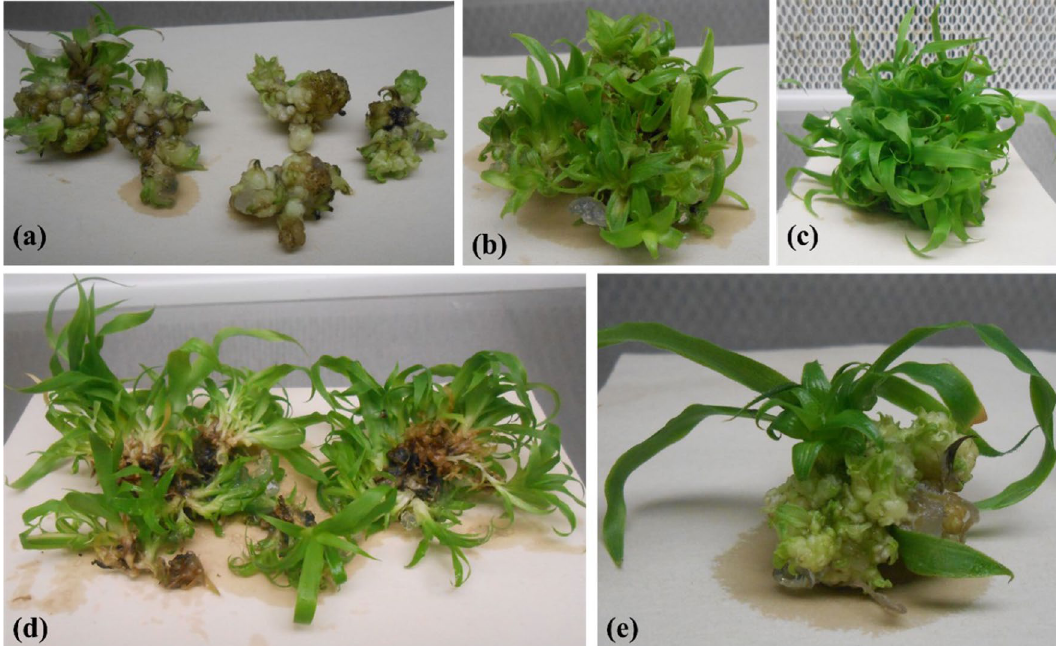
Figure 1. ( a ) Clusters of shoot buds, ( b ) Shoots emergence in the bud cluster, ( c ) Complete shoots formation in the bud cluster, ( d ) Isolation of shoots, ( e ) Formation of shoot bud cluster at the base of a